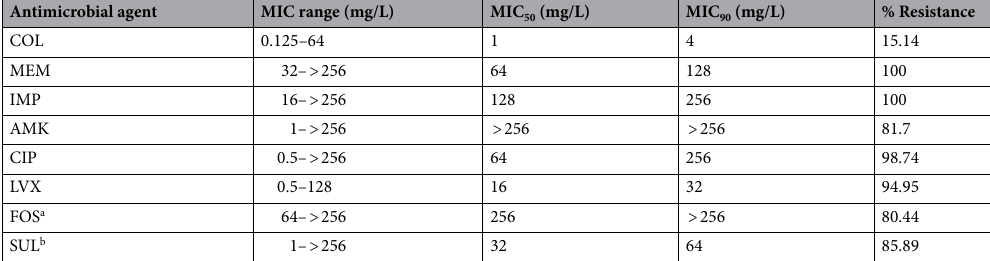
Table 1. Antimicrobial susceptibility of A. baumannii clinical isolates (n = 317). AMK amikacin, CIP ciprofloxacin, COL colistin, FOS fosfomycin, IMP imipenem, LVX levofloxacin, MEM meropenem, MIC minimum inhibitory concentration, SUL sulbactam. a The interpretation criteria for Enterobacteriaceae by the CLSI was used for fosfomycin susceptibility. b The interpretation criteria of ampicillin/sulbactam for Acinetobacter spp. by the CLSI was used for sulbactam